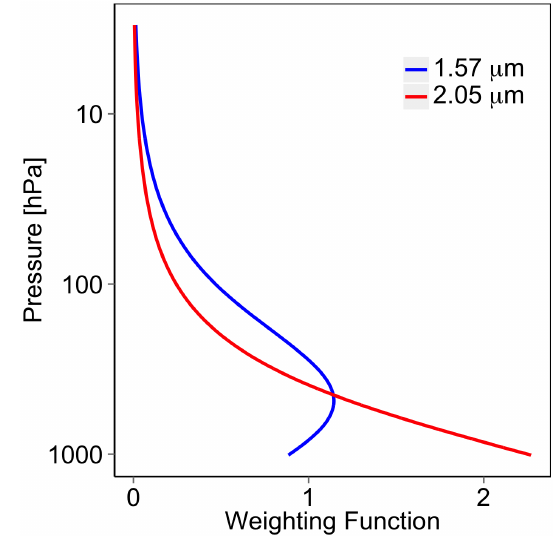
Figure 1. Vertical weighting functions perppmv of CO 2 (10 − 6 ppmv − 1 hPa − 1 ) for two candidate ASCENDS wavelengths. These relate differential optical depth lidar measurements (on-line minus off-line) to column-average CO 2 mixing ratios. The precise on-line wavelengths used here are 1.571121µm, which is 10 pi- cometers (pm) offset from line center, and